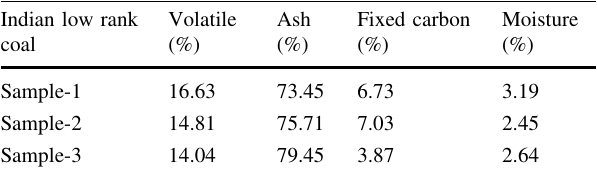
Table 2 Ultimate analysis of Indian low rank coal (dry-basis) Indian low rank